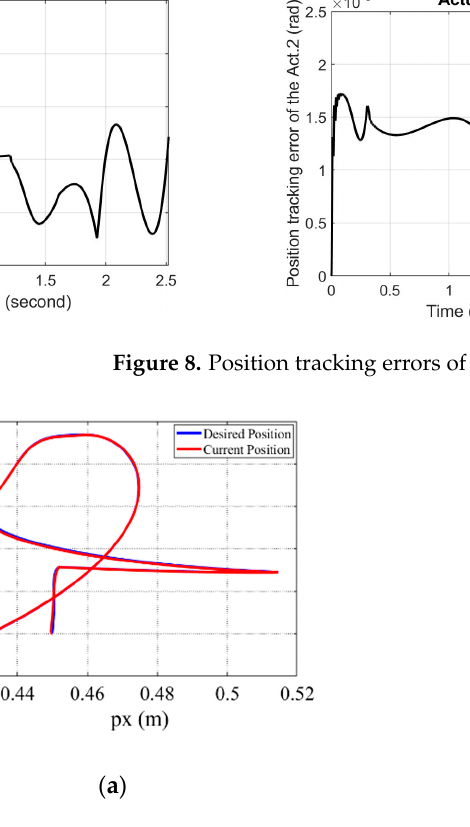
Figure 9. Cartesian tracking errors: ( a ) Cartesian position; ( b ) Cartesian error.